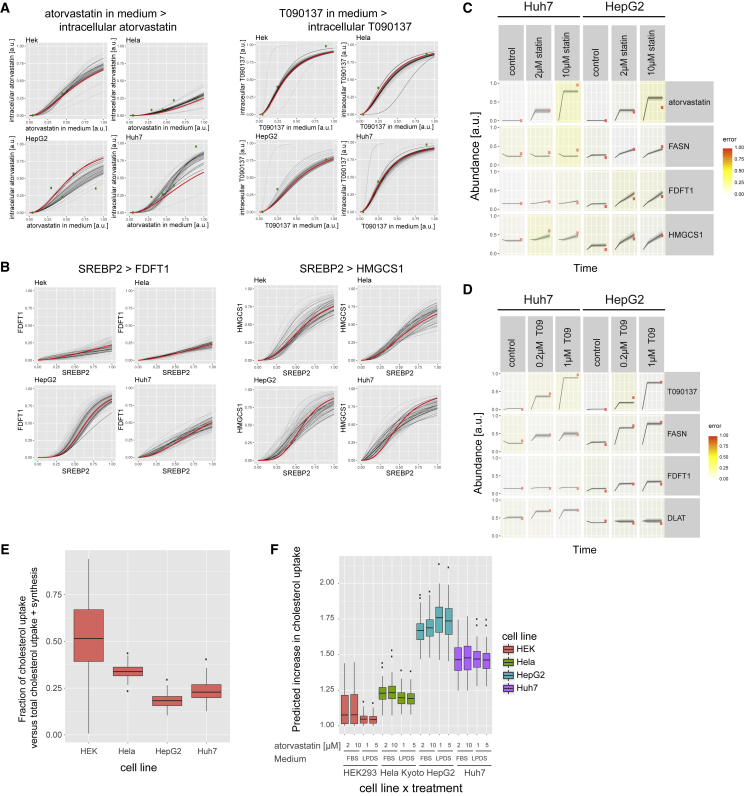
Comparing Cell-Line-Specific Models of Cellular Cholesterol Regulation(A) Transfer function (100 for each cell line) describing which intracellular drug concentration is approximated by the model for a given extracellular drug amount. Green dots indicate the manually defined input value and corresponding quantified intracellular concentration. The red curve depicts the transfer function from the best overall model; black curves show the functions for the 10% best fitting solutions.(B) Representation of transfer functions between SREBP2 and target proteins as explained above.(C and D) Depiction of models (lines) and experimental data (red dots).(E) Predicted fraction of cholesterol uptake versus total cholesterol uptake and synthesis.(F) Predicted increase in cholesterol uptake upon statin treatment.